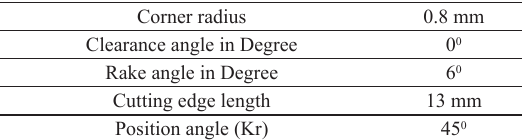
Table 3. Cutting tool insert specification.